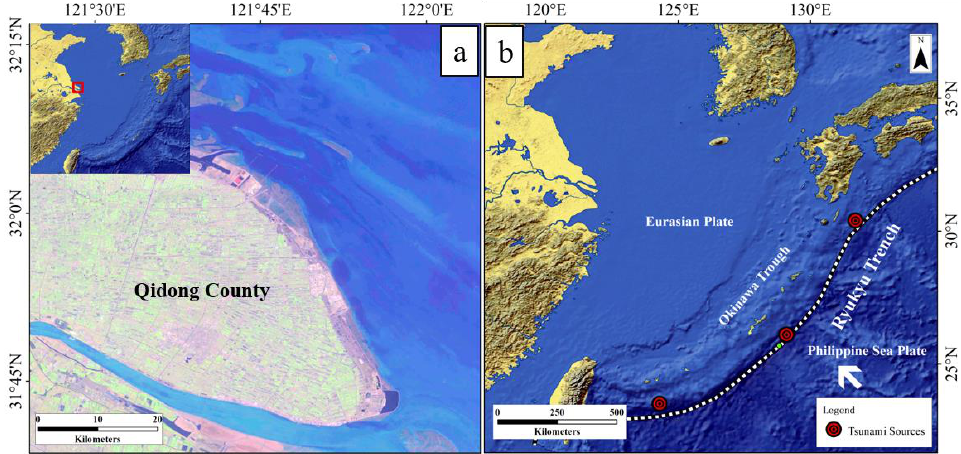
Figure 1. ( a ) Location of Qidong County. ( b ) Location of the potential tsunami sources considered in this study.